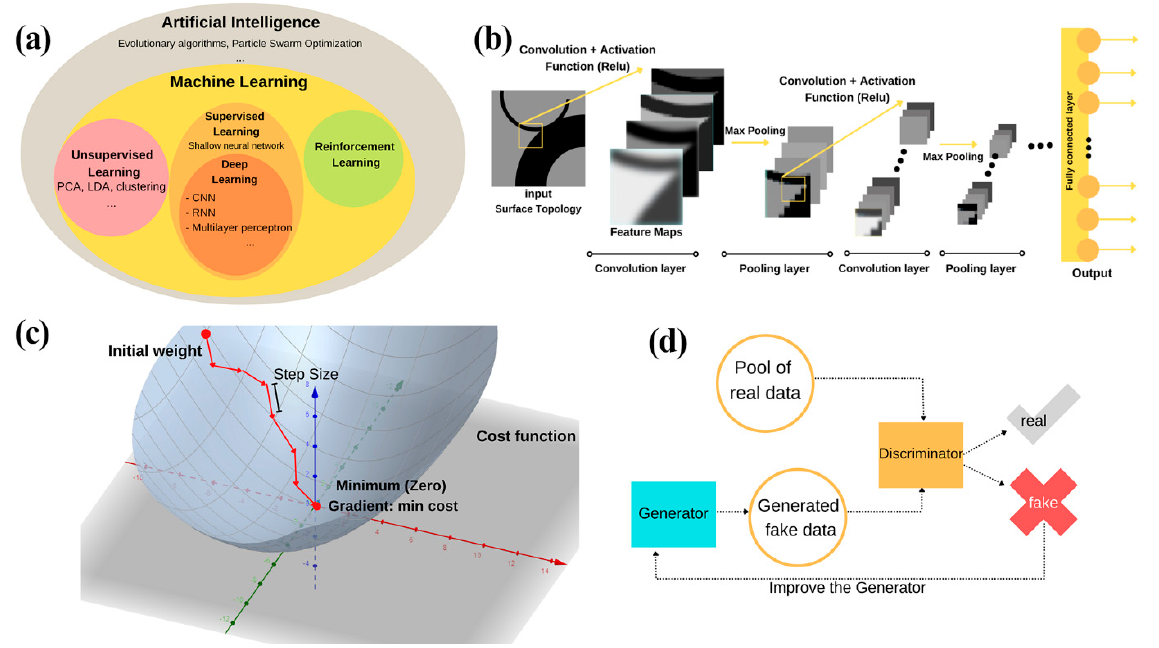
Figure 3. Overview of Artificial Intelligence methods. ( a ) The hierarchal structure of Artificial Intelligence methods. Machine Learning is among the methods of artificial intelligence. ML includes unsupervised learning, supervised learning, and reinforcement learning. ( b ) The structure of Convolutional Neural Network (CNN) in analyzing plasmonic device topology. Each convolution layer is followed by a pooling layer, where the downsized feature maps are generated. ( c ) Visualization of the gradient descent process. The weights are gradually optimized to reach the minimum discrepancy. ( d ) Flow Diagram of Generative Adversarial Network. The generator which generates counterfeit data is updated based on the feedback from the discriminator, which tells the authenticity of the incoming data.